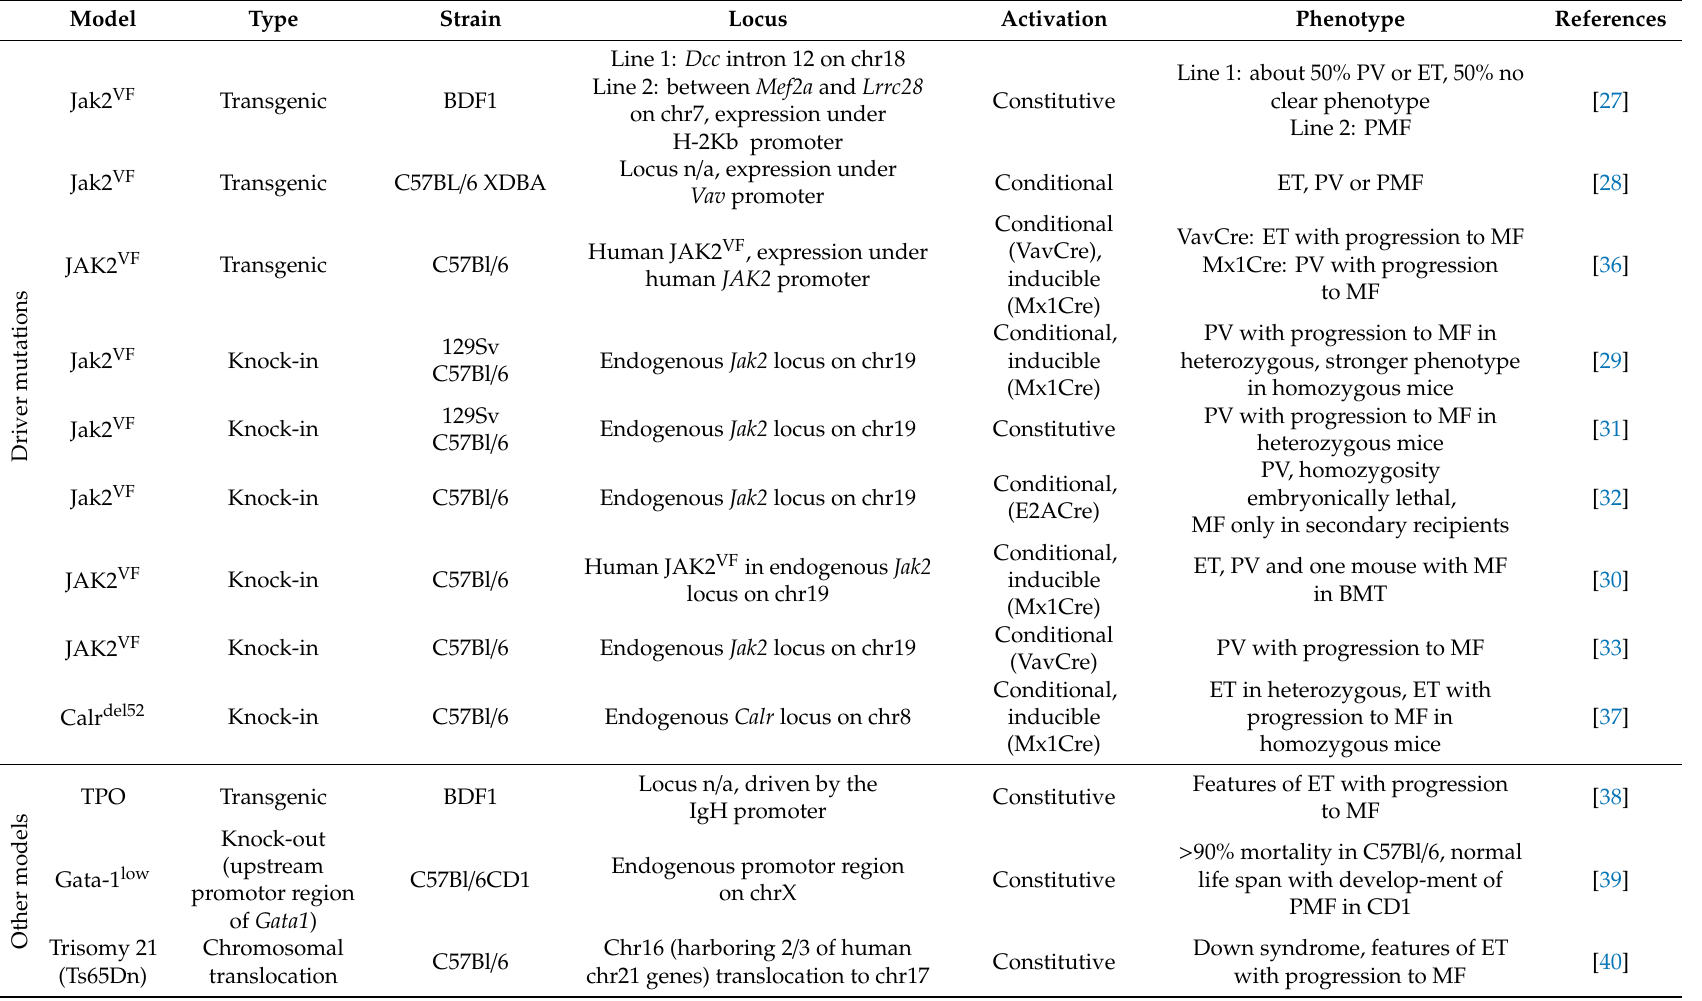
Table 2. Transgenic and knock-in mouse models of myelofibrosis. BMT: bone marrow transplant, ET: essential thrombocythemia, MF: myelofibrosis, PMF: primary myelofibrosis, TPO: thrombopoietin, PV: polycythemia